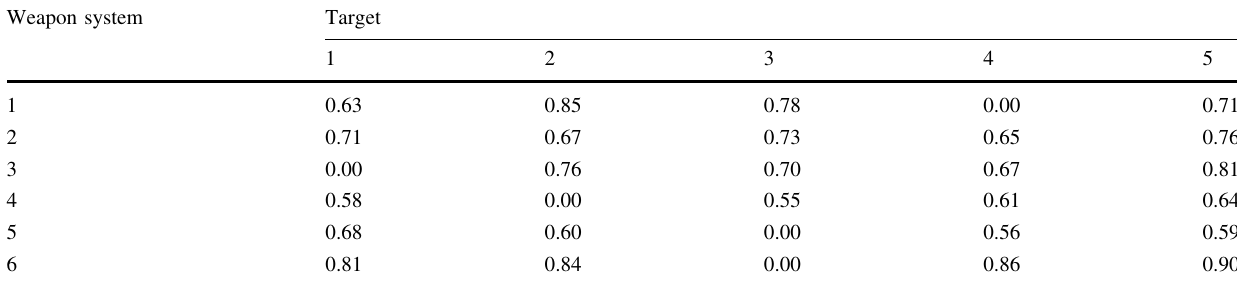
Table 9 Weapon damage probability for case 2 Weapon